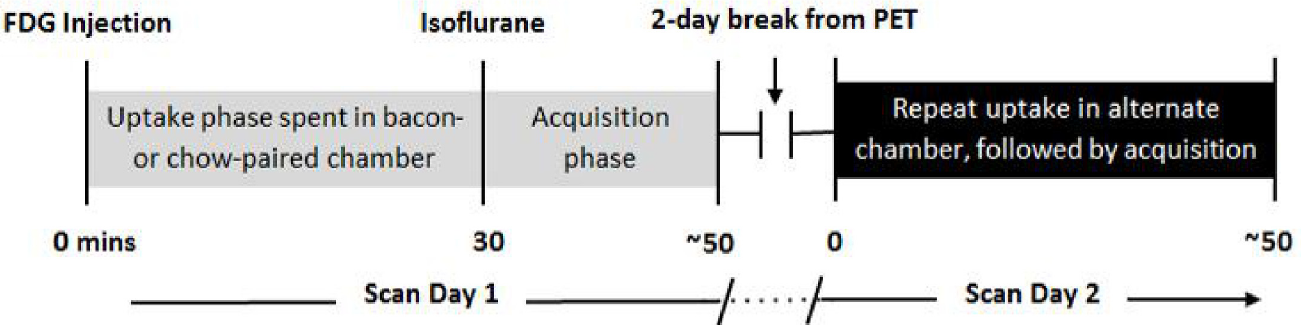
Fig 1. Scan day flow chart. Each animal was scanned twice, separately in the presence of either bacon- or chow-paired cues, but without either food stimulus. Animals were conscious during the uptake phase, and immediately prior to and during acquisition (20 min scan), animals were anesthetized with continuous isoflurane. During the 2-day break, CPP was maintained with one conditioning session per day (not